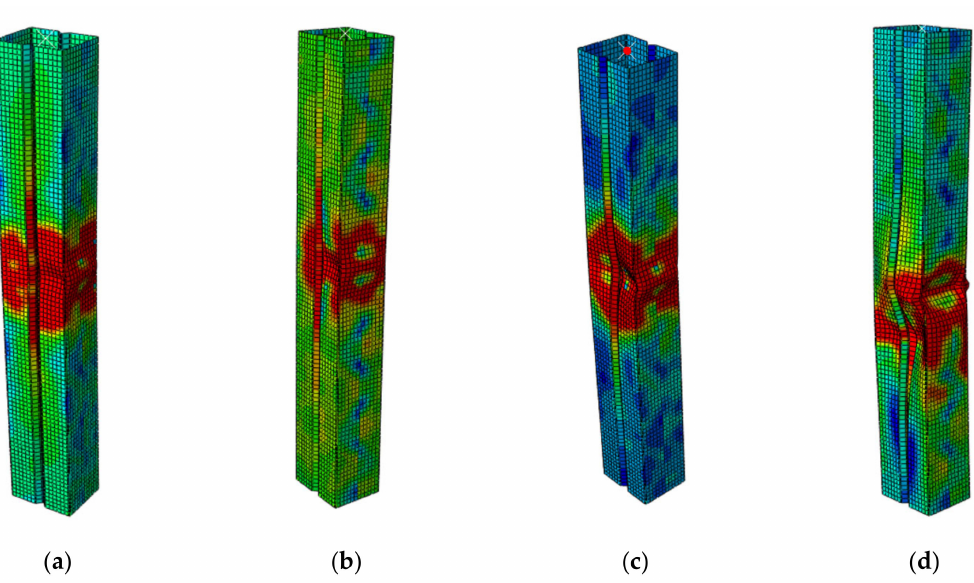
Figure 20. Deformed shapes from FEA at ultimate loads (FISCS-3). ( a ) Fy = 250 MPa. ( b ) Fy = 350 MPa. ( c ) Fy = 450 MPa. ( d ) Fy = 550